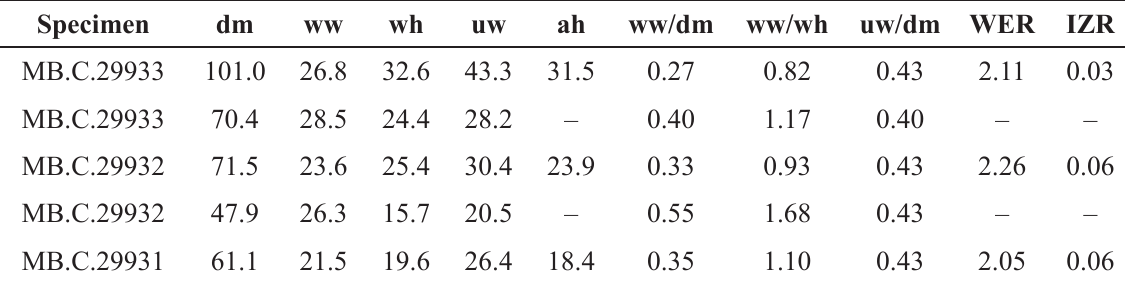
Table 18. Conch dimensions (partly estimated) and ratios of selected specimens of Paratirolites quadratus Korn & Ghaderi in Korn et al. (2016) from Baghuk Mountain.